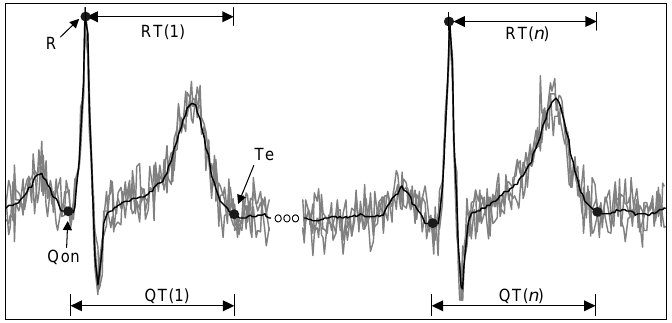
Figura 1. Pontos caracteristicos R e Te e intervalos QT e RT associados à repolarizaçao ventricular em um eletrocardiograma contaminado com ruído de banda larga de origem